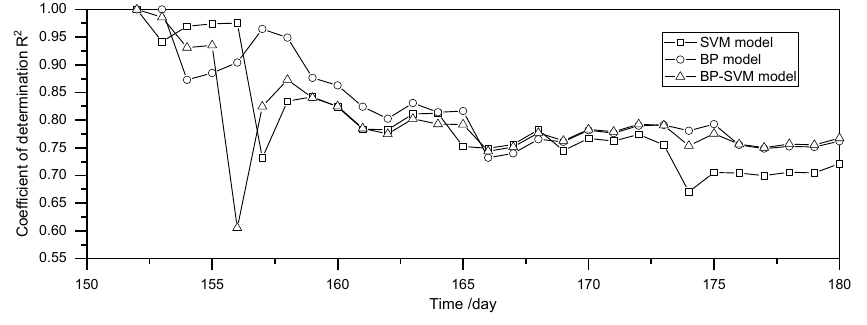
Figure 11. History curve of R 2 .